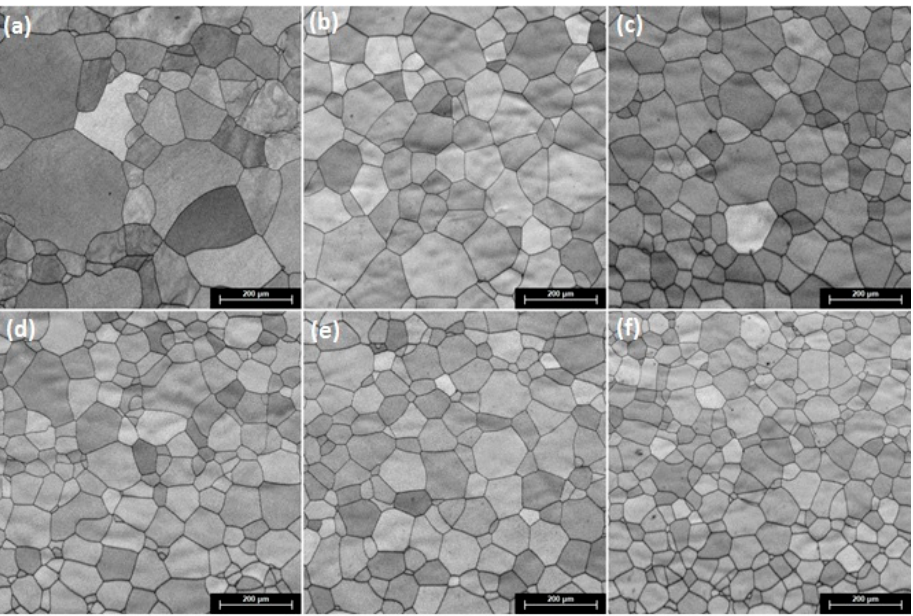
Figure 6. SEM images of the (CR + ST) processed samples corresponding to the 1st step of the 1st direction of the TMP Program, with various ε tot values for CR and similar STs for all six samples: 1223 K/15 min./w.q.: ( a ) CR( ε tot = 10%) + ST; ( b ) CR( ε tot = 20%) + ST; ( c ) CR( ε tot = 30%) + ST; ( d ) CR( ε tot = 40%) + ST; ( e ) CR( ε tot = 50%) + ST; ( f ) CR( ε tot = 60%) + ST. Metals 2020 , 10 , x FOR PEER REVIEW